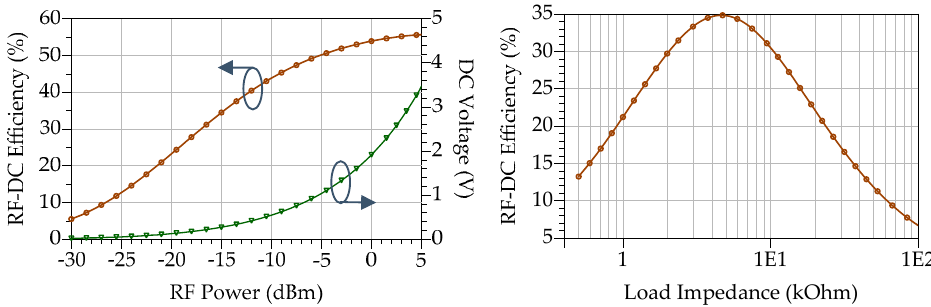
Figure 5. RF-DC Power conversion efficiency of the textile rectifier for different RF power levels ( left ) and load impedances ( right